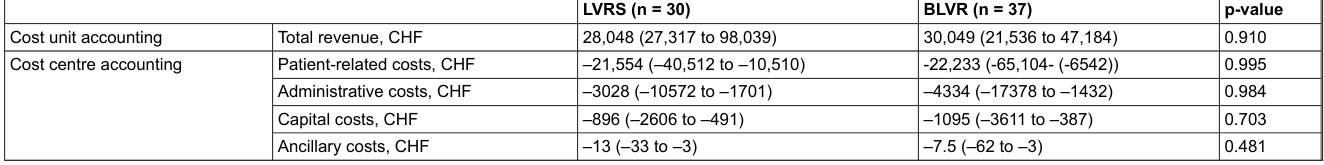
Table 5: Median cost unit and cost centre accounting by method of lung volume reduction.